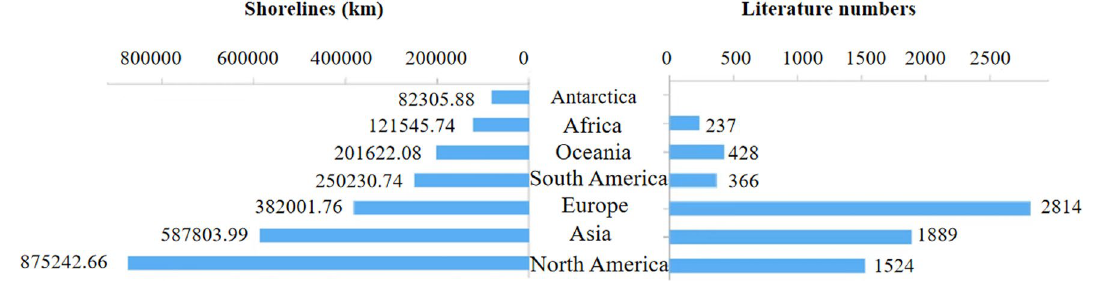
Fig. 4 Number of relevant literature versus shorelines by